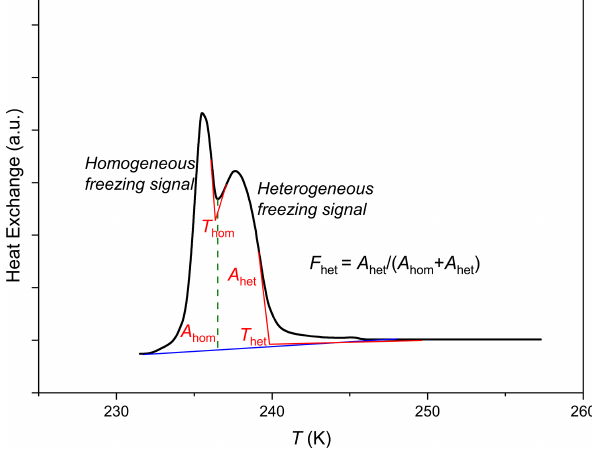
Figure A1. A typical DSC thermogram showing freezing onset temperatures T het and T hom and the asymptotes used for their con- struction (red lines), as well as evaluation of F het . The area under each peak corresponds to the volume of water that froze homoge- neously ( A hom ) or heterogeneously ( A het ). The straight blue line connects the onset of heterogeneous freezing signal with the end of the homogeneous freezing signal and is taken as the baseline for evaluating the total frozen fraction. The dashed vertical green line marks the minimum intensity between the homogeneous and het- erogeneous freezing peak and is taken as the separator between the areas under the heterogeneous and homogeneous freezing